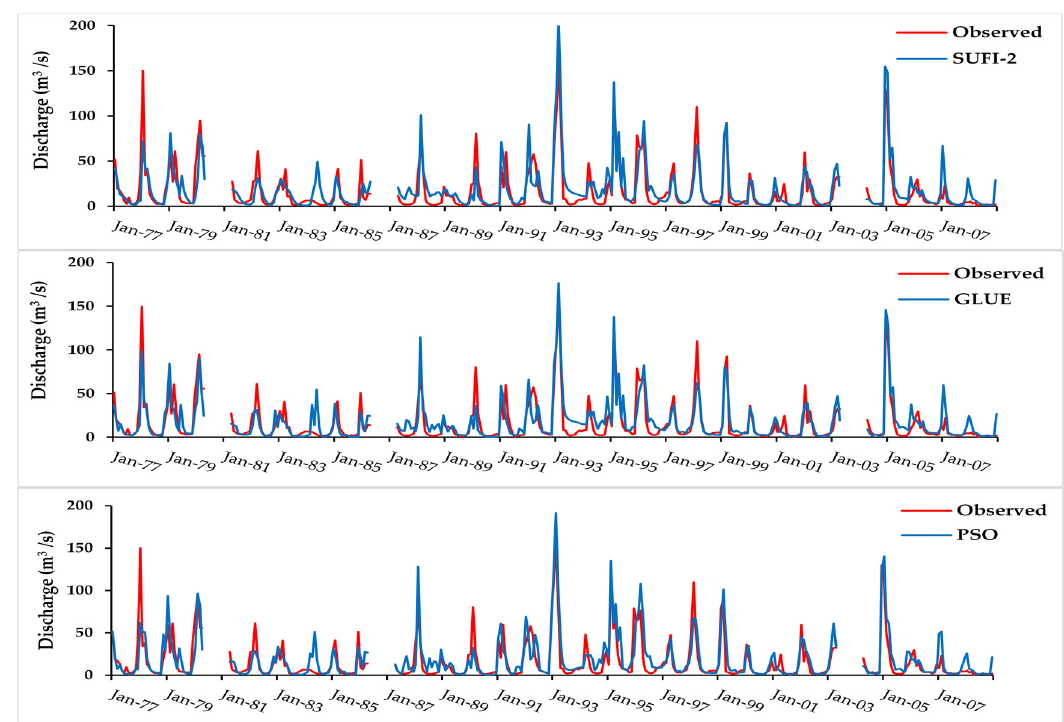
Figure 6. Calibration (1990–2008) and validation (1977–1989) results of the monthly simulated discharges using the three optimization algorithms (SUFI-2, GLUE, and PSO), with NSE as the objective function in the T.Karzin station in Salman Dam Basin (SDB).